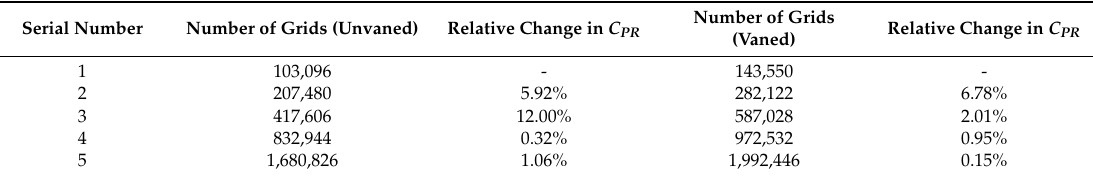
Table 2. Mesh sensitivity analysis.